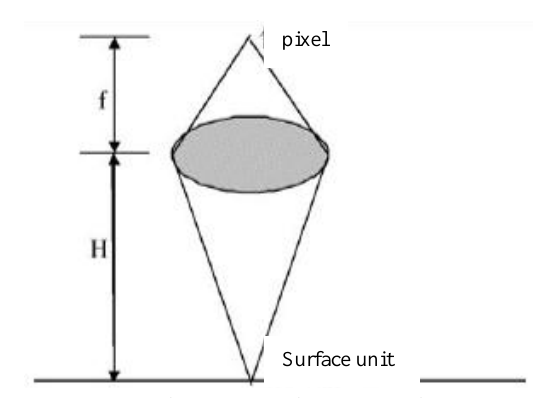
Figure 1. Law of the inverse of the square of illumination